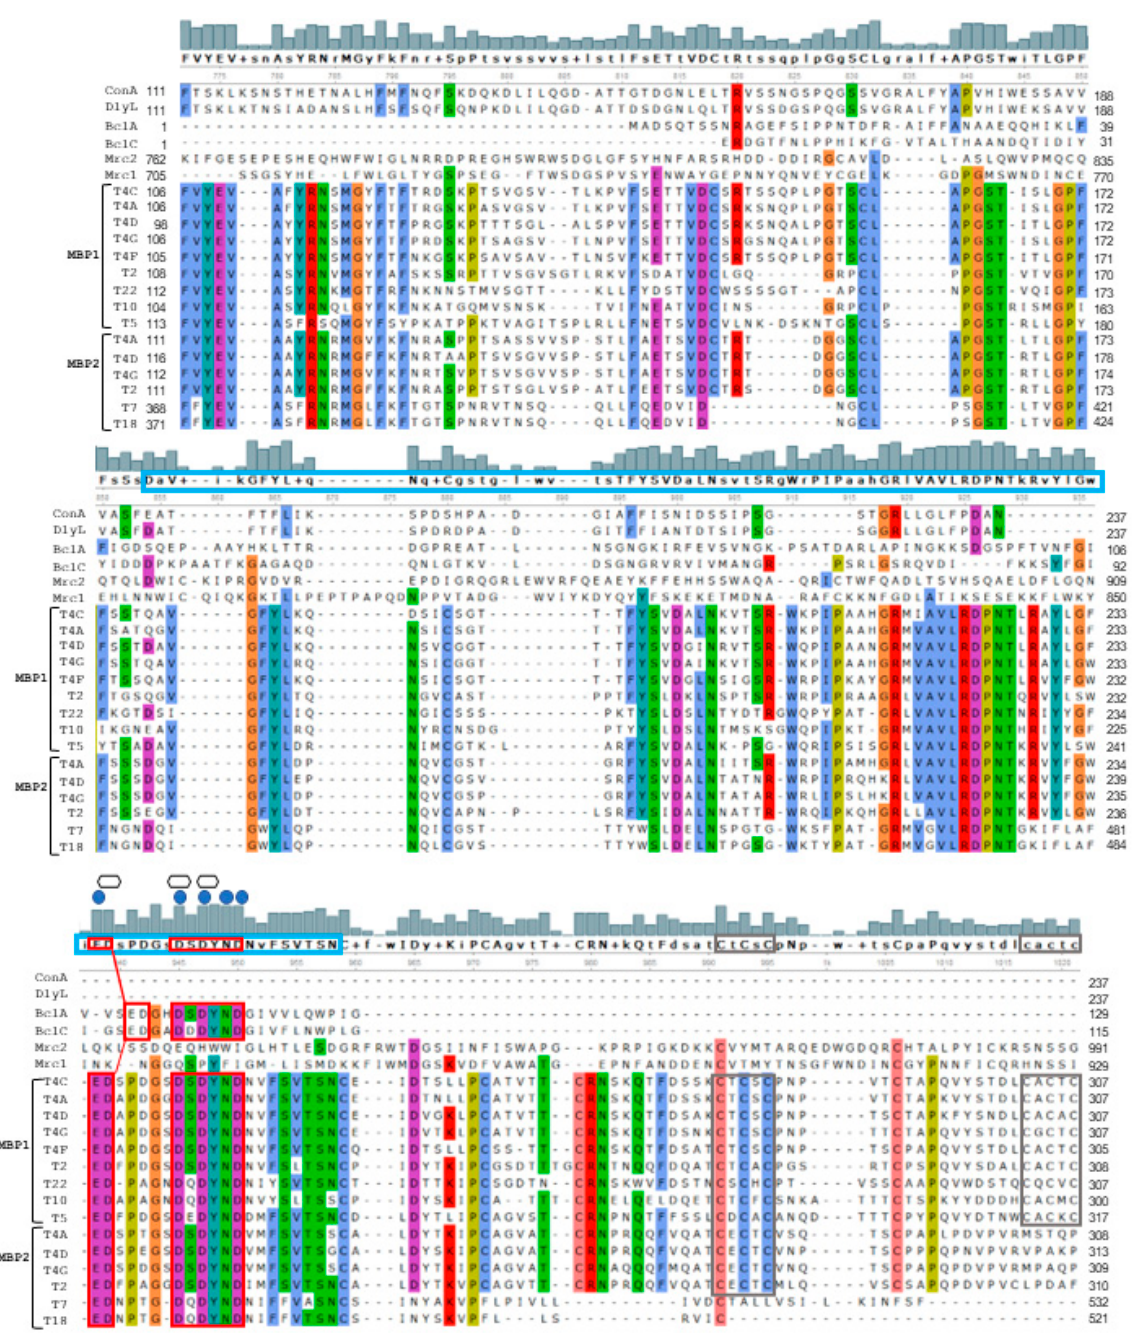
Figure 5. Multiple alignment of Acanthamoeba MBP1 and MBP2 with other C-type lectins. Only part of the alignment is shown here, focusing on the DUF 4114 domain, marked with a light blue rectangle in the consensus sequence. The following sequences were used: Concanavalin A (ConA; PDB: